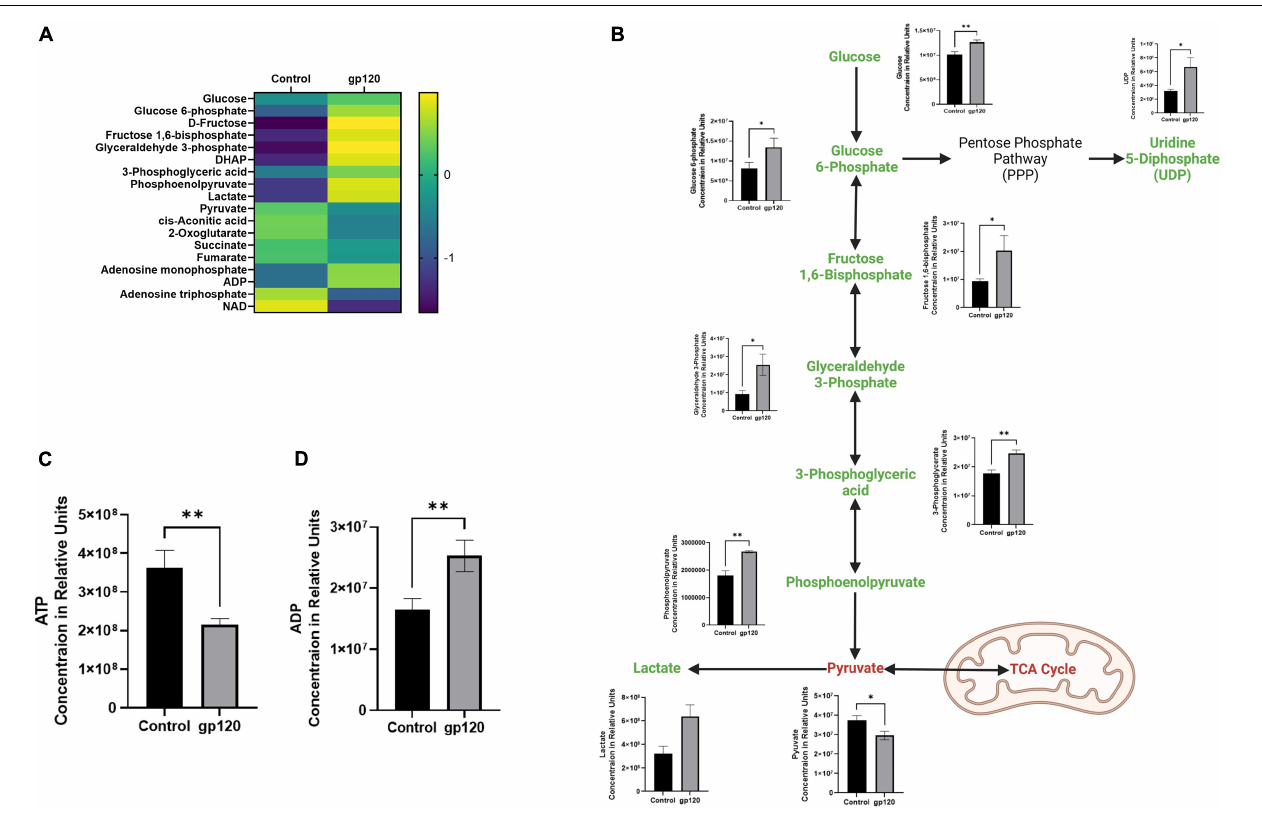
FIGURE 2 | Alterations in glycolysis after gp120 treatment. (A) Differential expression of metabolites measured in untreated and gp120-treated LUHMES cells in triplicate by metabolomic analysis. ( p < 0.05). (B) Glycolysis pathway with metabolites that are upregulated (green) and downregulated (red) in LUHMES treated with gp120 compared to control cells. Graphs next to each metabolite show changes in associated metabolites between control and gp120 treated LUHMES. (C) ATP and (D) ADP concentrations in LUHMES treated with gp120 compared to control cells. Bar Graphs black bars are control samples, gray bars are gp120 treated samples ( ∗ p < 0.05, ∗∗ p <